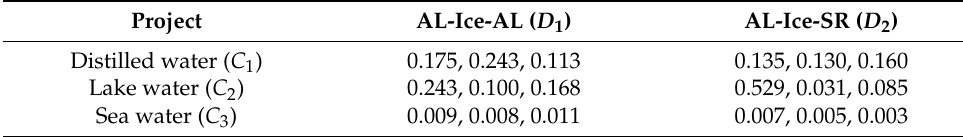
Table 11. Test data of the orthogonal relationship between water quality and